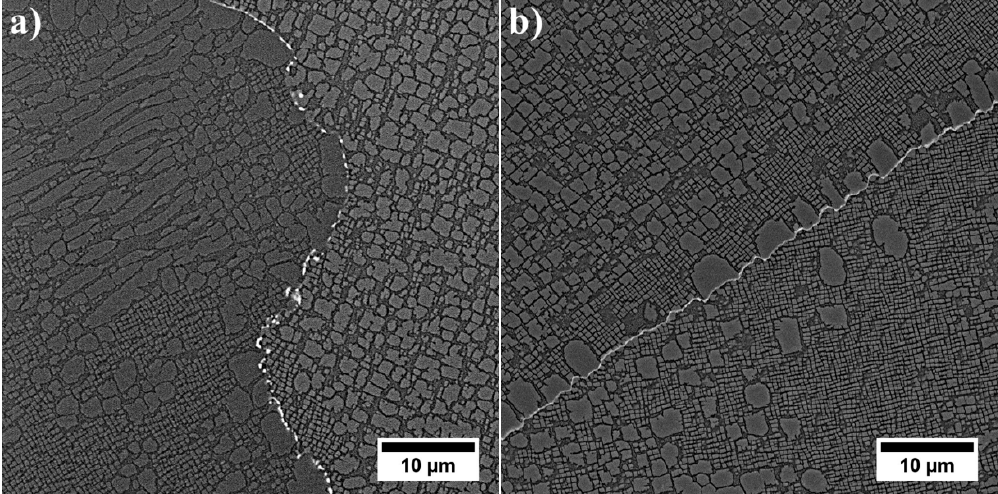
Figure 8. Graphical representation of selected concentration relationships between alloying elements in carbides. Based on the SEM-EDX point analysis.